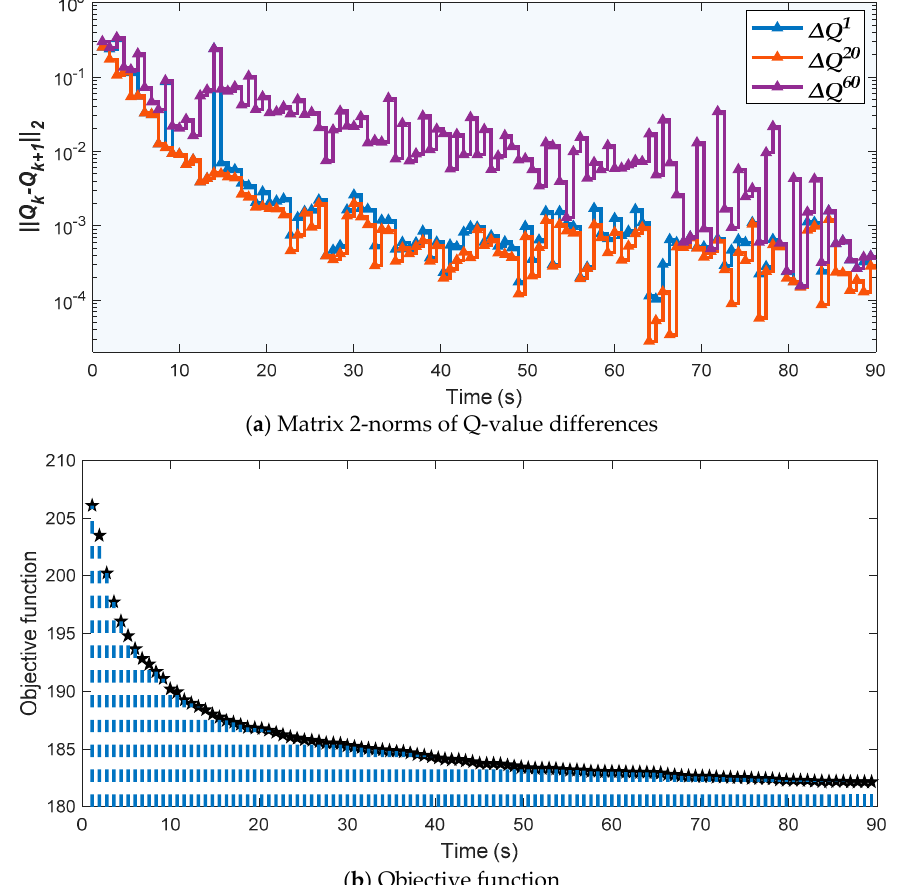
Figure 7. Convergence of the eighth source task of the IEEE 300-bus system obtained in the pre-learning process.